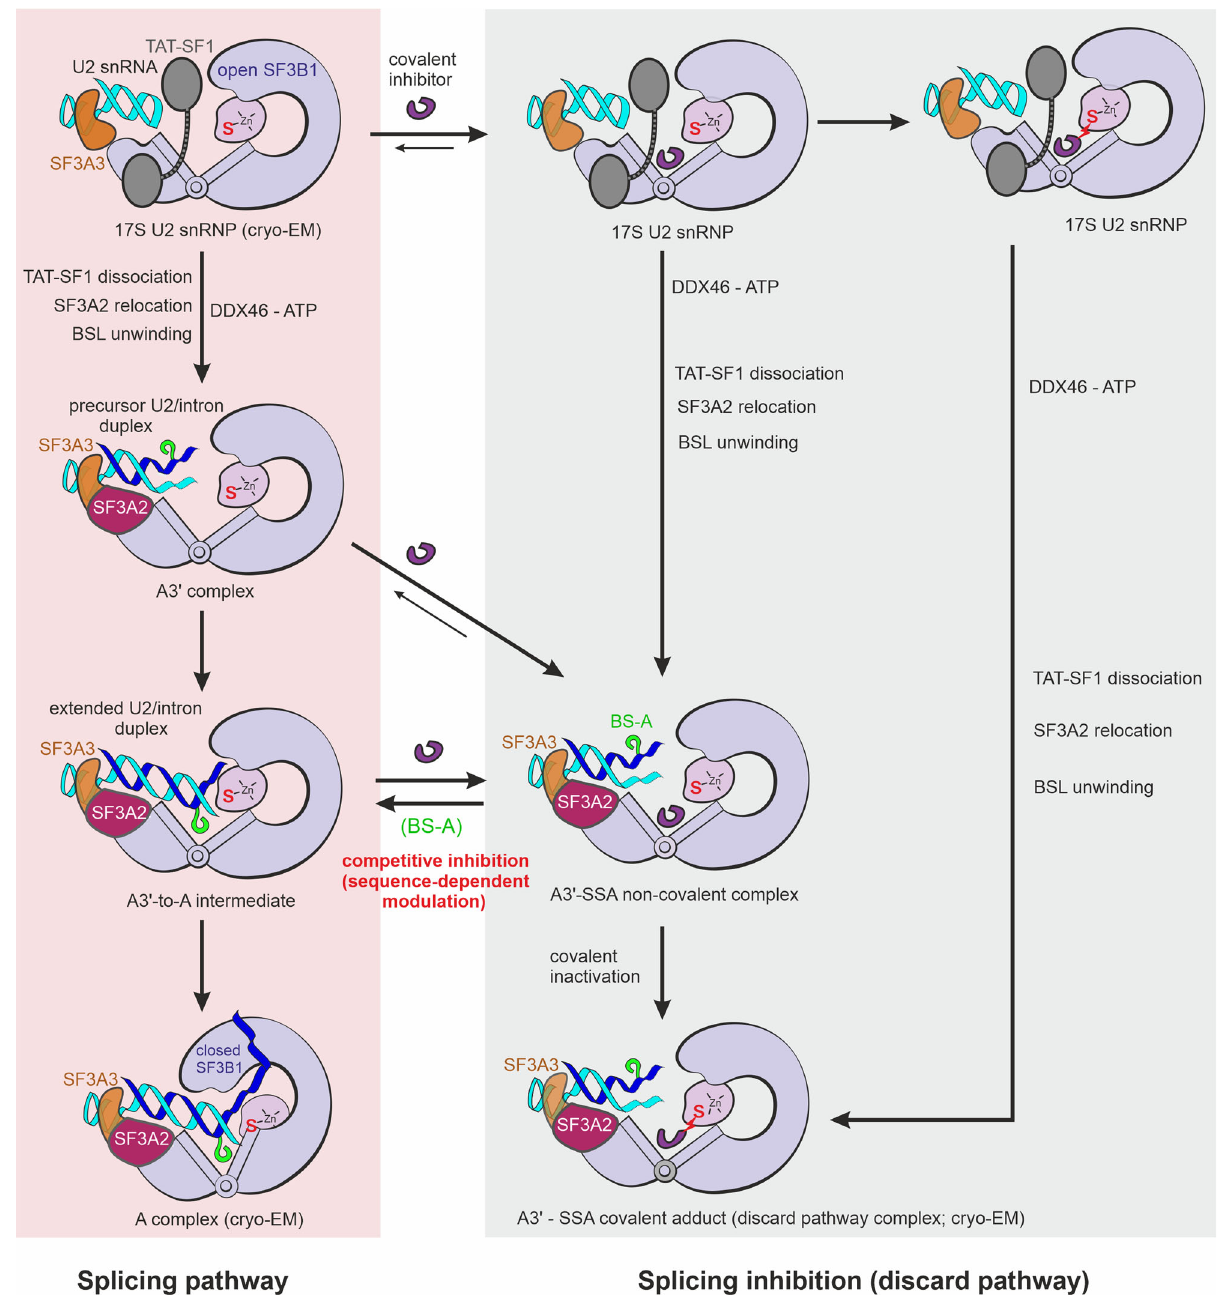
Fig. 7 Model of the early splicing pathway under normal and drug-induced conditions. The two pathways are presented in two columns, on distinct backgrounds. Note that modulators can enter the splicing pathway at various stages upon binding the hinged pocket in the open conformation of SF3B1. The competitive inhibition depends on the intron sequence at the BS and occurs before the chemical coupling of covalent inhibitors, thereby leading to differential inhibition of splicing (i.e., modulation). After covalent coupling, the complexes are irreversibly inactivated, resulting in global inhibition of splicing. Except for the indicated covalently inactivated states, the proposed schematic might be largely valid for non-covalent inhibitors as well, including pladienolide derivatives or SSE. The structures determined by cryo-EM are indicated. The SSA-bound 17S U2 snRNP complexes are inferred from the accessibility of the inhibitor ’ s binding pocket within the cryo-EM structure of the 17S U2 snRNP (PDB 6Y50). The putative transitions between the SSA- bound 17S U2 snRNP and A3 ′ -SSA are inferred from the apparent absence of sterical interference between the bound inhibitor, the intron, and exchanged prespliceosome As in the case of our previous recombinant SF3B core, SF3B Δ BPB had an apparent acid contaminants were then concentrated by ultra fi ltration using the Amicon Ultra-15 centrifugal fi lter (50 kDa MWCO, Merck) and further applied to a HiLoad 1:1:1:1 stoichiometry and, as expected, eluted later from the size-exclusion column 16/600 Superdex 200 pg column (GE Healthcare) pre-equilibrated in the gel (with a retention volume of ~11.02mL vs. ~10.63mL) 34 . Overall, this indicates that fi ltration buffer (20 mM HEPES-KOH pH 7.9, 400 mM KCl, 5% (v/v) glycerol, the removal of the BPB domain of SF3B3 did not signi fi cantly affect the structural 1mM TCEP). SF3B Δ BPB peak fractions were then concentrated by ultra fi ltration to organization and the solution behavior of the remaining subunits or weaken/ destabilize the protein – protein interaction interfaces of SF3B Δ BPB . ~8 – 10 mg/mL, aliquoted and fl ash-frozen in liquid nitrogen, and stored at − 80°C.